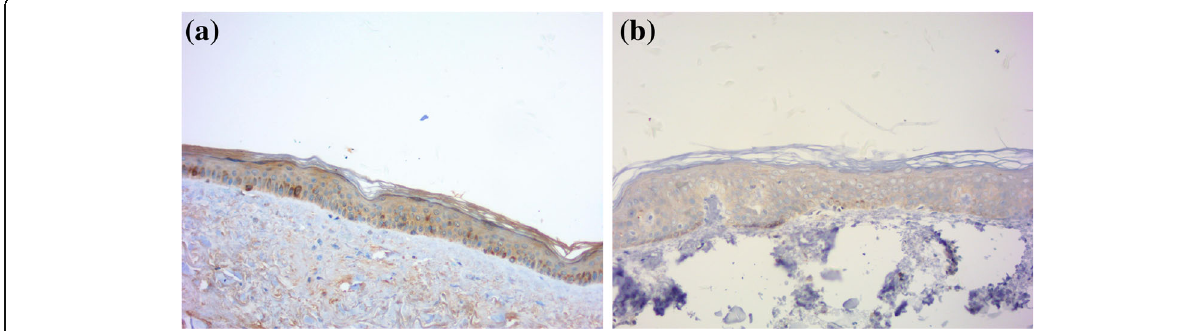
Fig. 1 AHR and CYP1A1 in normal skin. a Weak positive AHR immunoreactivity with a cytoplasmic pattern in epidermis. b Weak CYP1A1 immunoreactivity with a cytoplasmic pattern in epidermis. (immunoperoxidase